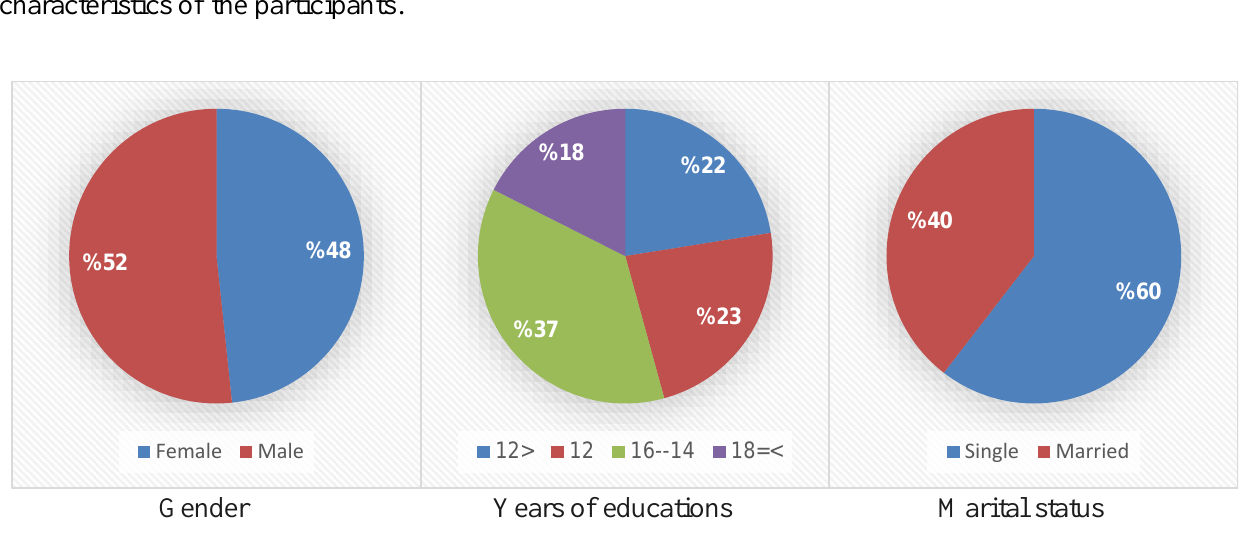
Fig. 1. Personal characteristics of the